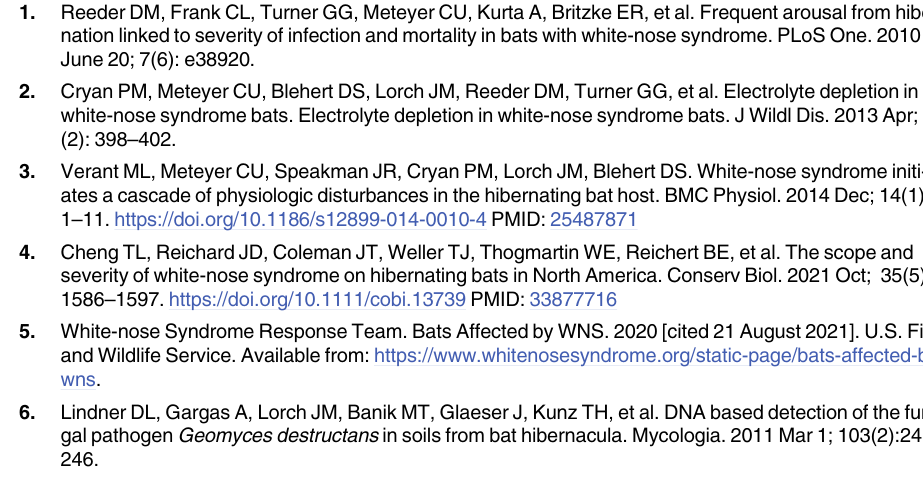
S5 Fig. Structural equation model for visitor willingness to comply with year long cave clo- sures.